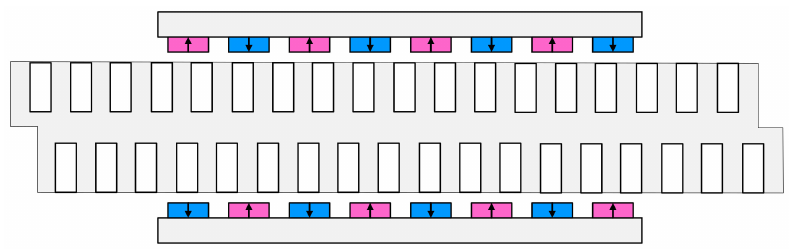
Figure 8. Simulation model of the cogging force.